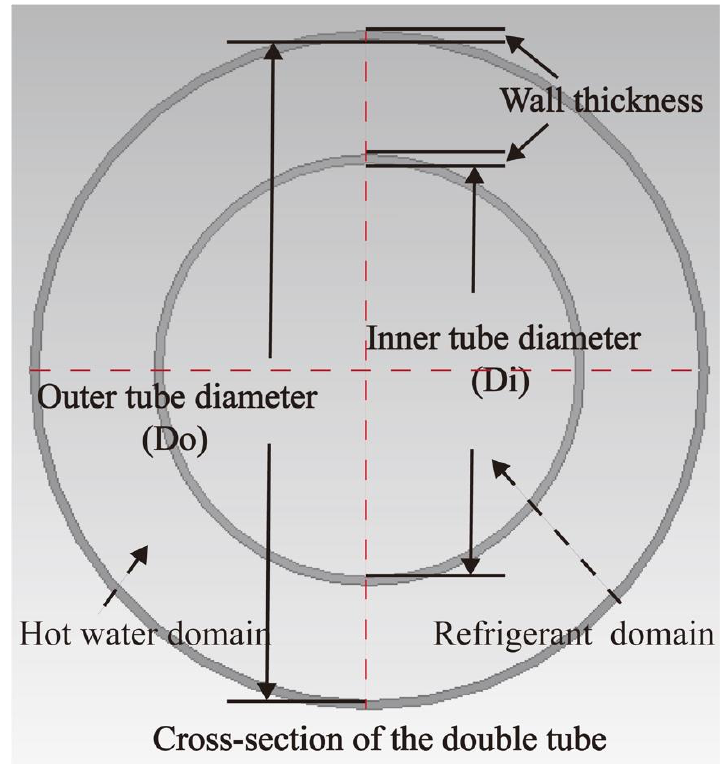
Figure 1. The cross-section of the double-concentric pipe. Table 1. The dimensions of the double-concentric pipe.